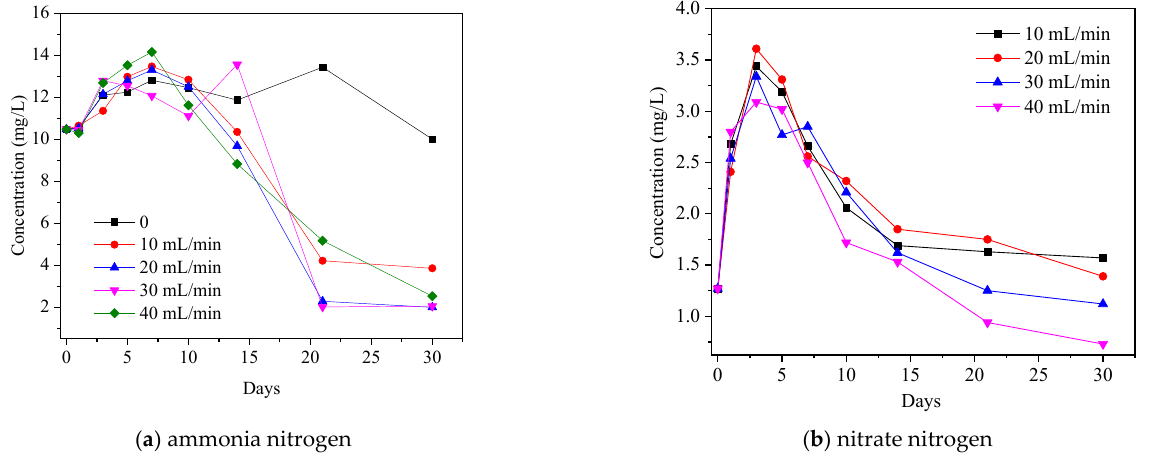
Figure 4. Variation of ammonia nitrogen/nitrate nitrogen concentrations in overlying water under aeration.